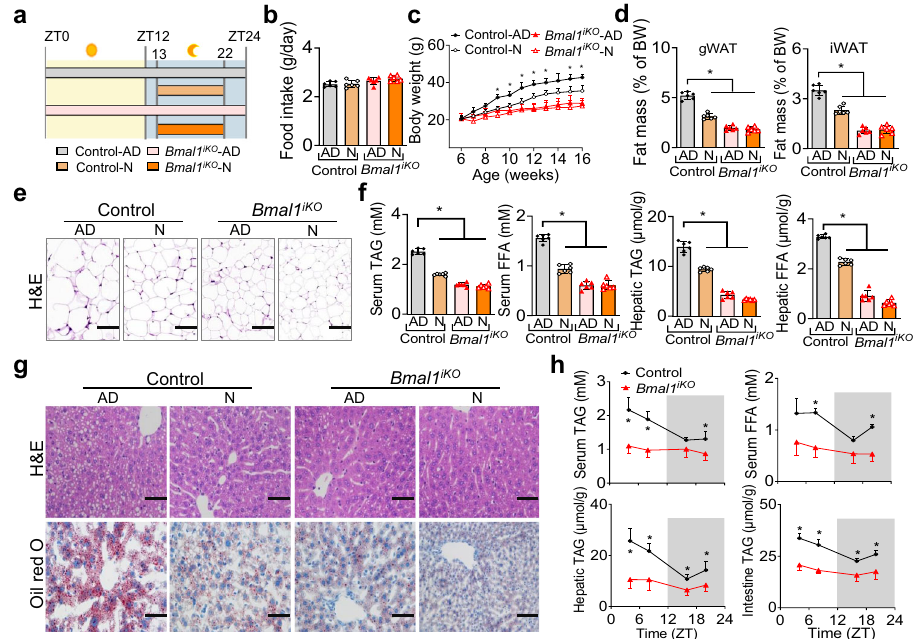
Fig. 3 Nighttime feeding ameliorates HFD-induced obesity in a Bmal1 -dependent manner. a Schematic diagram of nighttime feeding and feeding ad libitum (on HFD). Mice with nighttime feeding had access to HFD for 9 – 10h in the dark period from ZT13 to ZT22/23. AD, ad libitum , N, nighttime. b Daily food intake of Bmal1 iKO and control mice fed ad libitum or with nighttime feeding. c Body weight curves of mice over 10 weeks feeding. p values (Control-AD vs Control-N, from left to right): 0.7144, 0.3415, 0.1321, 0.0121, 0.0104, 0.0153, 0.0023, 0.0055, 0.0512, 0.0031 and 0.0005 (two-way ANOVA and Bonferroni post